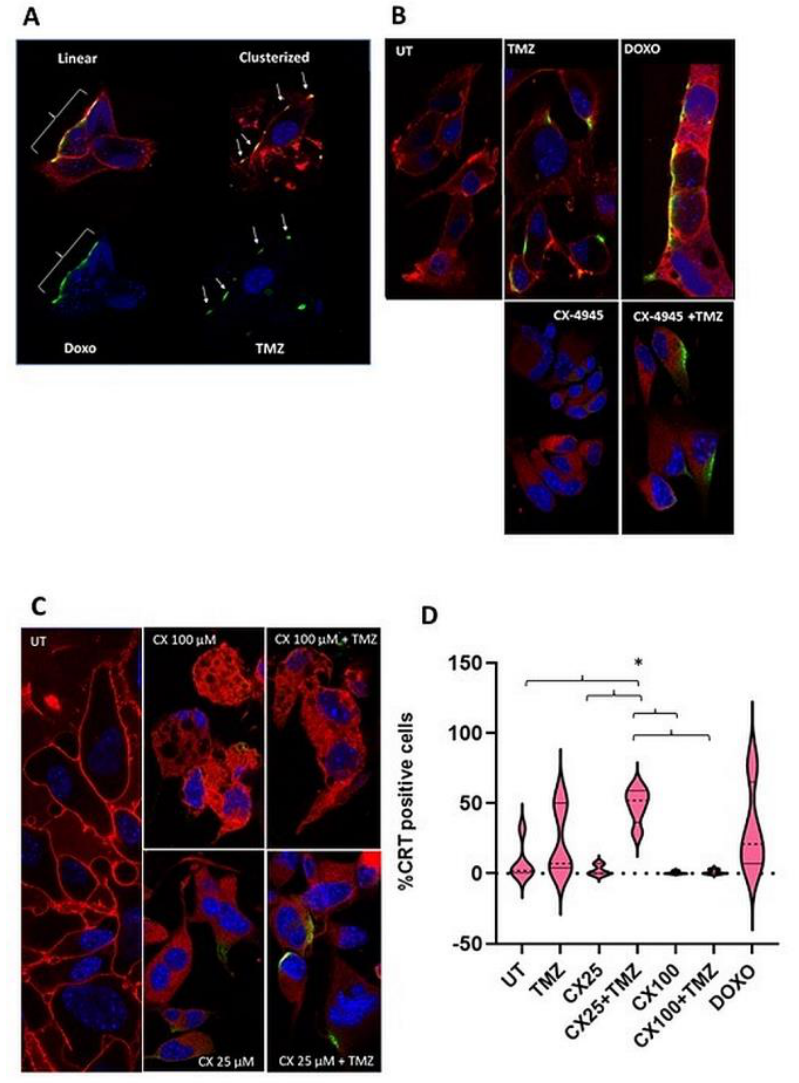
Figure 3. CRT exposure in the GL261 cells plasma membrane after treatment. Nuclei were stained with Hoechst dye 33,342. White brackets and arrows indicate lineal or clusterized CRT, respectively. Membranes were stained with Cell Mask and shown in red. ( A ) Example of CRT exposure in its different conformations. Top: membranes are shown in red, nuclei in blue, and CRT in green, with the overlay CRT/membrane shown in yellow. Bottom: only nuclei (blue) and CRT in green are shown. On the left side, Doxo-treated cells (50 µ M, 24 h of treatment) show CRT in a linear, elongated conformation (green). On the right side, TMZ-treated cells (2 mM, 24 h of treatment) show a clusterized, focal pattern of CRT exposure. TMZ-treated cells had nuclei stained with Hoechst dye. In Doxo-treated cells, Doxo prevents the union of Hoechst and the nuclear structures. Hence, blue staining corresponds to autofluorescence of the nuclei-bound Doxo itself. ( B ) Immunofluorescence staining for all conditions studied. All treatments were performed for 24 h: TMZ (2 mM), CX- 4945 (CX, 25 µ M), TMZ+CX-4945 (2mM, 25 µ M) and Doxo (50 µ M). ( C ) Comparison between CRT exposure staining in 24 h treatments of CX-4945 and CX-4945+TMZ at two different concentrations of CX-4945 (CX, 25 and 100 µ M). ( D ) Violin plots indicating the quantitation of CRT-exposing GL261 cells upon treatment with the conditions explained in ( B , C ). The percentage of positive cells is shown (n = 3–5 for each case). Median is shown in dotted lines, while quartiles are shown with continuous lines. UT, untreated cells. “*” states for p < 0.05 for the indicated